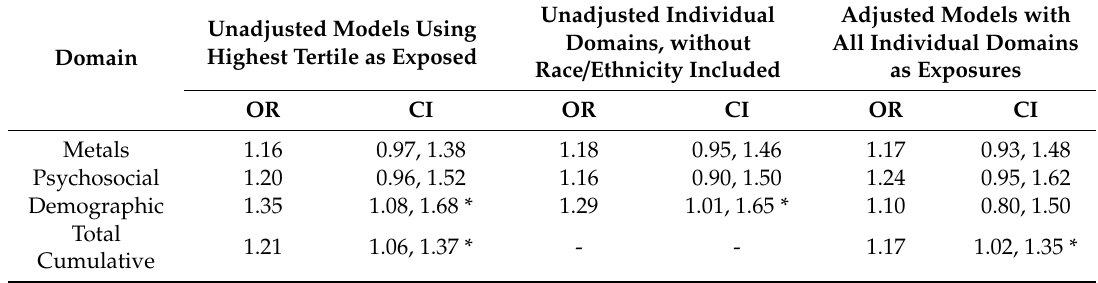
Table 4. Unadjusted and adjusted associations between composite variables for three domains (metals, psychosocial stress, and demographics) and SGA, the Fetal Growth Study *.